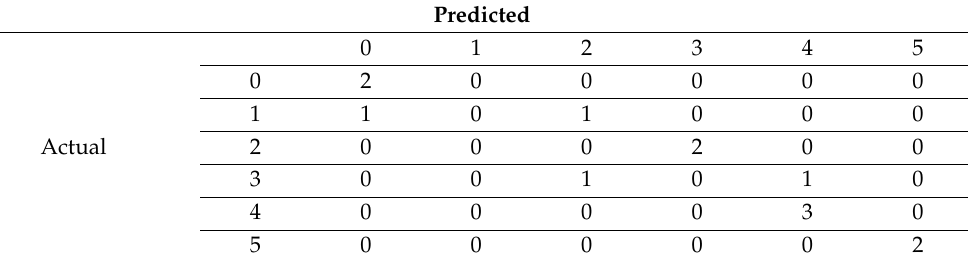
Table 5. Linear discriminant analysis (LDA). Accuracy: